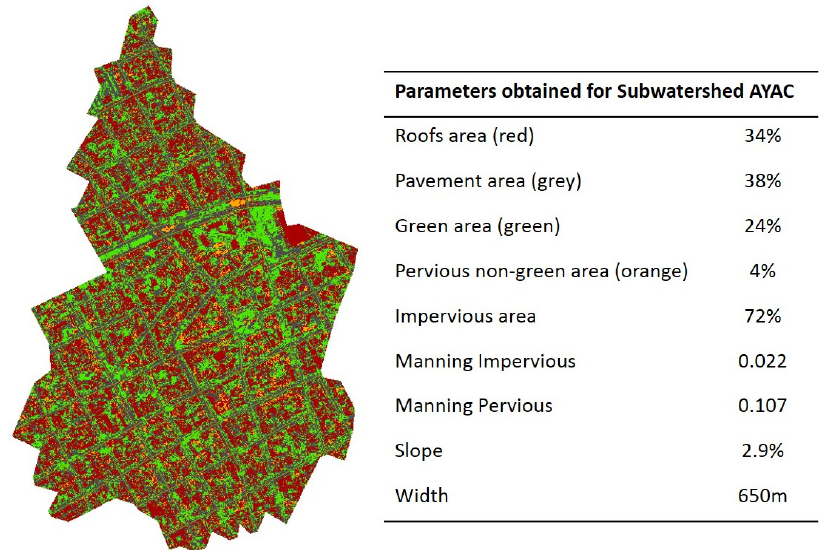
Figure 5. Results obtained from data analysis for subwatershed AYAC (location given in Figure 4).